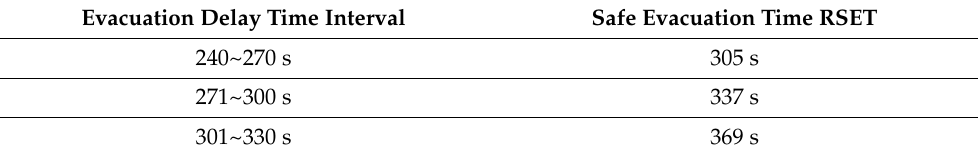
Table 3. Simulation results of the safe evacuation time under different evacuation delay times.